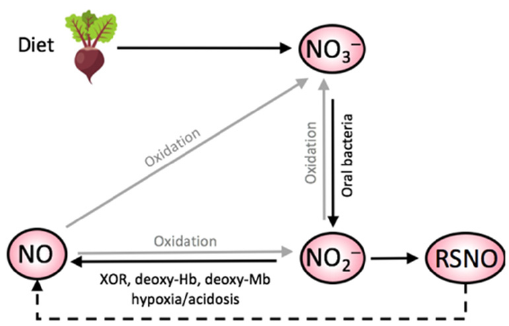
Figure 1. A schematic diagram of the nitrate–nitrite–nitric oxide (NO 3 − –NO 2 − –NO) pathway, which is facilitated by environments of low oxygen tension and acidosis. The conversion of NO 2 − to NO occurs via various enzymatic reactions; S-nitrosothiols (RSNO) can decompose to form NO. XOR = xanthine oxidoreductase; deoxy-Hb = deoxyhemoglobin; deoxy-Mb =